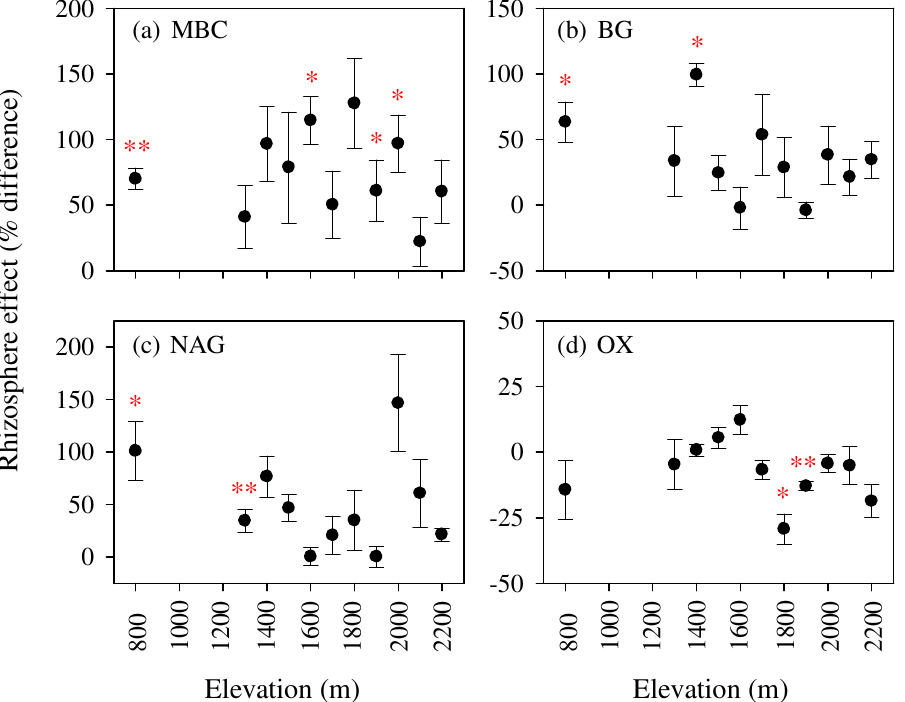
Figure 3. Relationship of the rhizosphere effects on microbial biomass carbon (MBC, ( a )), β −glucosidase (BG, ( b )), N−acetyl− β −glucosaminidase (NAG, ( c )) and oxidase (OX, ( d )) with elevation. There was no significant linear regression ( p > 0.05). For each elevation, values are the means and error bars are the standard errors of replicated plots ( n = 4). Asterisks indicate significant differences between rhizosphere soil and bulk soil based on paired−samples t −tests (* p < 0.05 and ** p < 0.01).